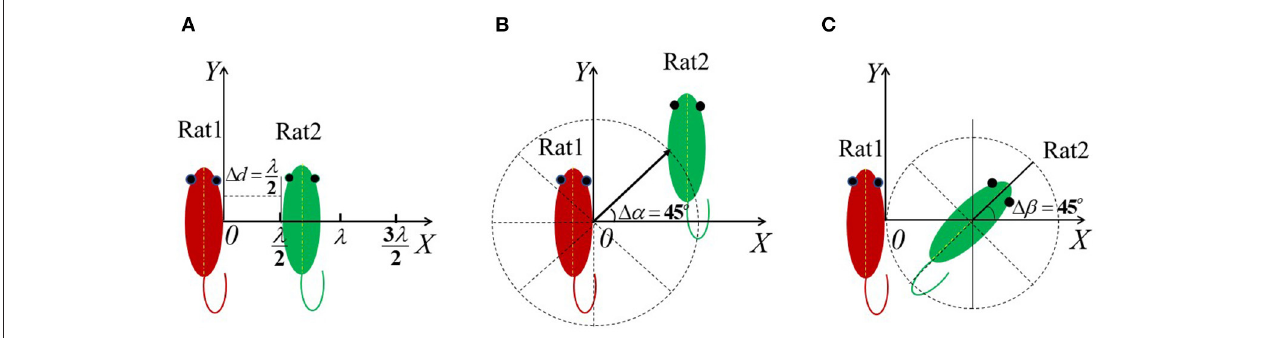
FIGURE 2 | Illustration of the variation manner of d , α , and β used for numerical simulation. (A) The variation manner of d; (B) The variation manner of α ; (C) The variation manner of β